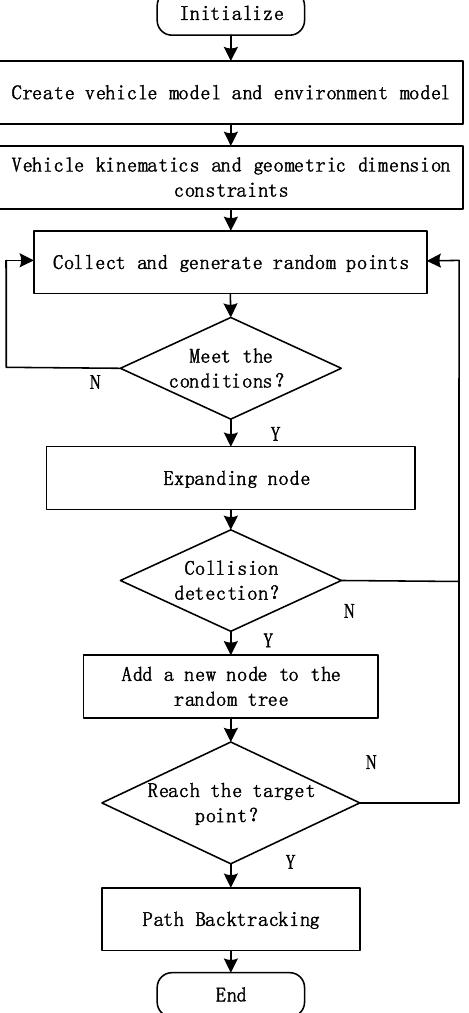
Figure 1. Flow chart of improved RRT algorithm.